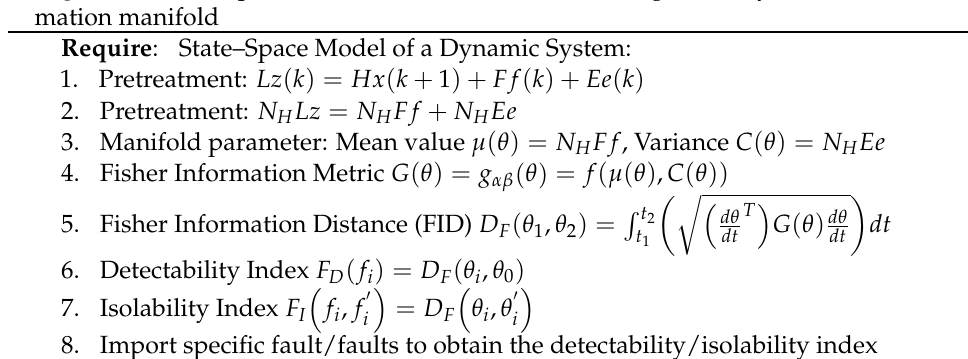
(cid:0) (cid:1) = F D f gy 1.55741 (cid:16) (cid:17) = F D f hy